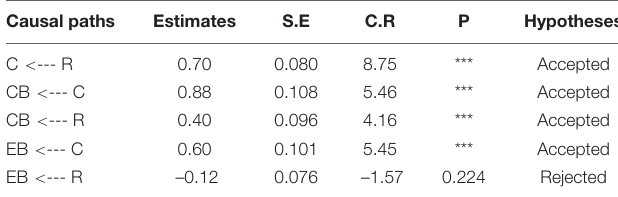
TABLE 3 | SEM regression